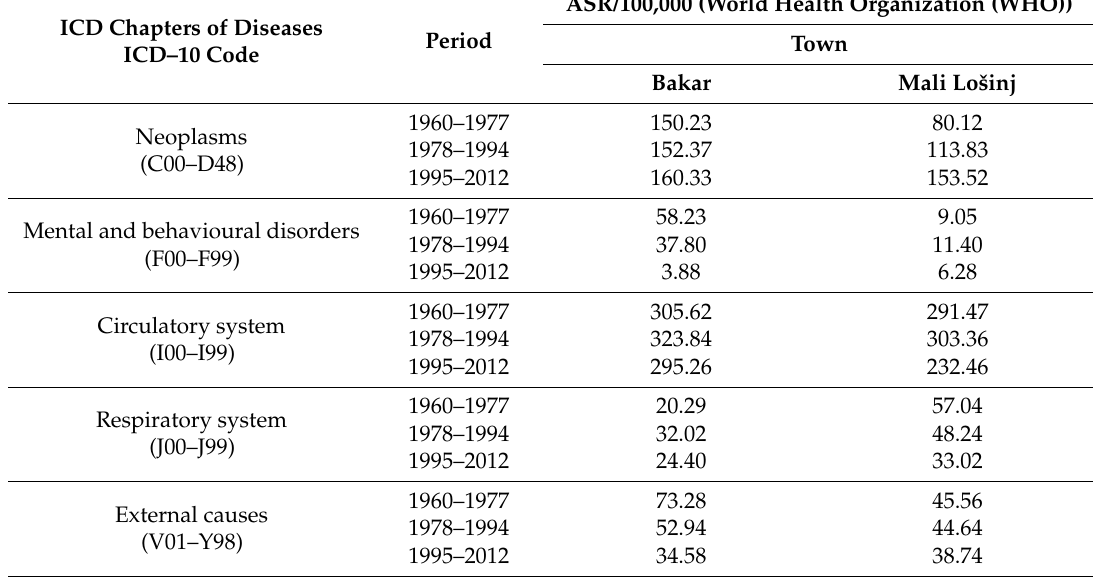
Table 3. Average age-standardised mortality rates for the towns of Bakar and Mali Lošinj for the leading causes of death according to disease group in three studied